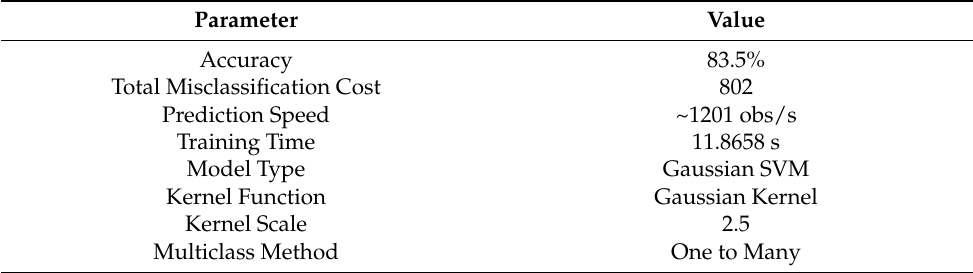
Table 5. Support vector machine characterization.